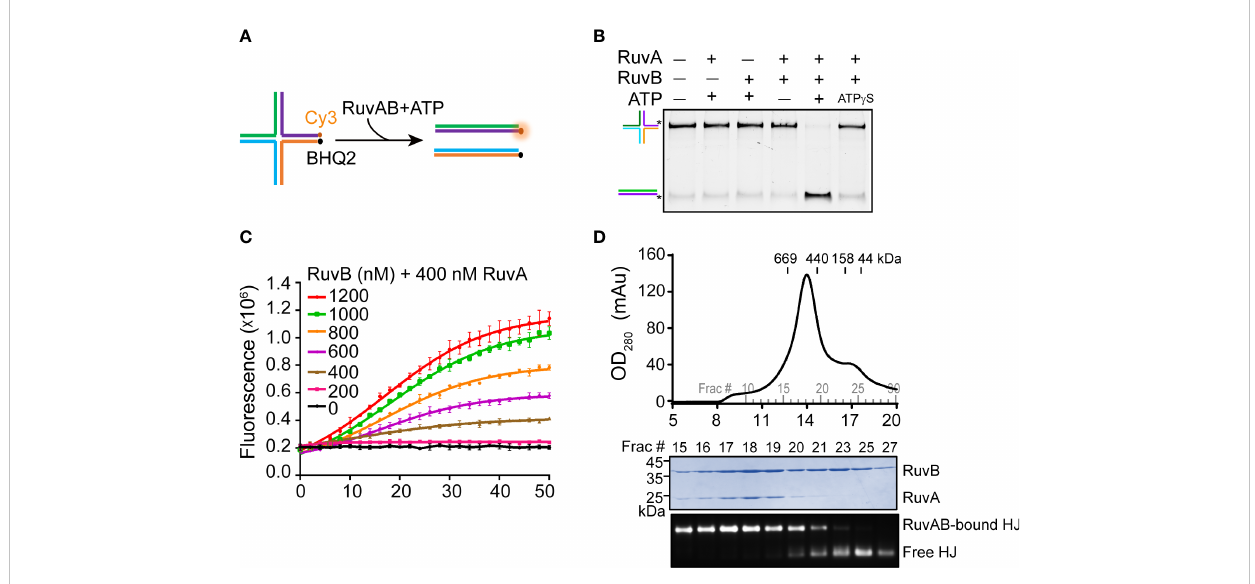
FIGURE 1 Reconstitution of the PaRuvAB-HJ complex. (A) Schematic representation of HJ branch migration by the PaRuvAB complex assayed by the FRET- based duplex unwinding assay. The complete sequences are listed in Supplementary Table S1. HJ strands are labeled with Cy3 fl uorophore and BHQ2 quencher as indicated. (B) The native polyacrylamide gel analysis of HJ DNA unwinding by the RuvA and RuvB proteins. HJ strands are color- coded as in (A) , and fl uorescently labelled with 6-carboxy fl uorescein (FAM) as indicated by asterisks (*). (C) Real-time monitoring of branch migration activities of RuvA (400 nM) with increasing amounts of RuvB. The fl uorescent signal was recorded every 2 min (mean ± s.d., n = 3 independent experiments). (D) Size-exclusion chromatography of the PaRuvAB-HJ complexes (top panel) and Coomassie-stained gel of proteins and agarose gel of HJ-DNA eluted from the column (bottom